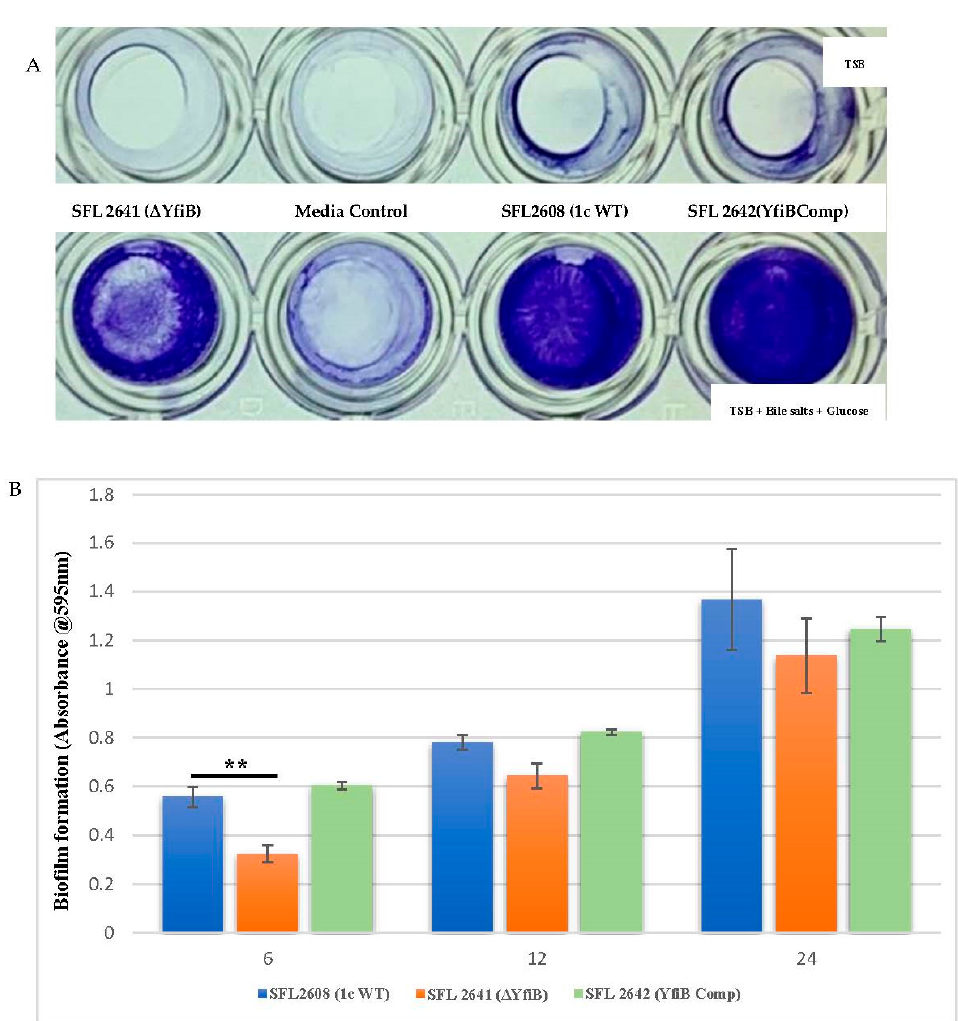
Figure 3. Quantification of biofilm formation by S. flexneri strains. ( A ) Examination of biofilm formation in plate wells when grown with and without bile salts in TSB media at 6 h. Biofilm formation was performed in a 96-well plate, the 1c WT (SFL2608), yfiB KO mutant SFL2641 ( ∆ YfiB) and yfiB -complemented strain SFL2642 (YfiBComp) were cultured in Tryptone Soy Broth (TSB) medium with and without bile salts and glucose for 6, 12, and 24 h static. The observed biofilm was stained using crystal violet and assessed by determining the optical density at 595 nm (OD595). ( B ) Biofilm formation of 1c WT (SFL2608), yfiB KO mutant SFL2641 ( ∆ YfiB), and yfiB -complemented strain SFL2642 (YfiBComp) at 6, 12, and 24 h; at 6 h, considerable difference was seen between the WT strain and yfiB KO mutant. The Y-axis represents the biofilm amount relative to the blank media. A Student’s t-test was conducted for pairwise comparison of the biofilm formation and the analysis was based on three independent biological repeats, with each assay undergoing at least four technical repeats. The two asterisks represent the variation observed being statistically significant ( p < 0.01) and error bars depict the standard deviation of data based on the three independent